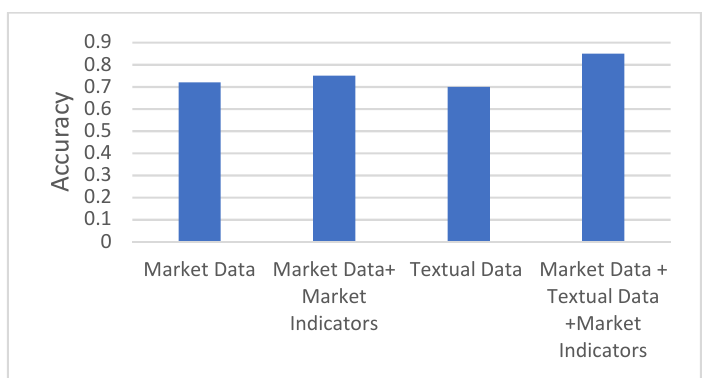
Figure 7. Comparison of the accuracies with different types of data.